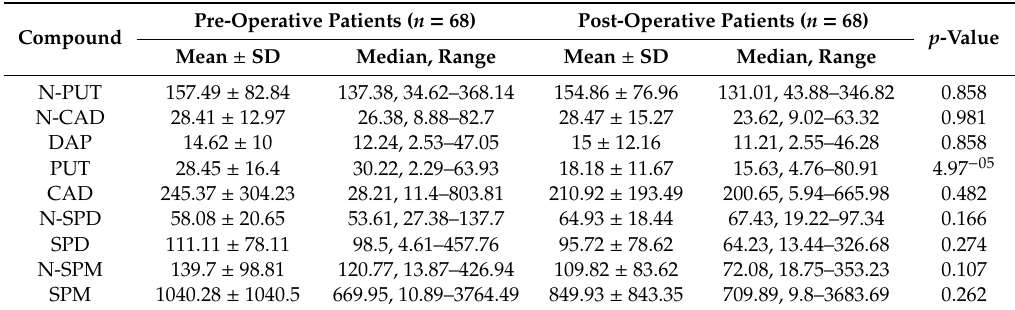
Table 2. Concentrations of nine polyamines in serum samples from pre- and post-operative patients with colorectal cancer (ng / mL).